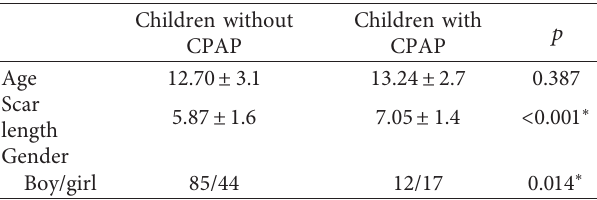
Table 2: Children characteristics according to chronic post- appendectomy